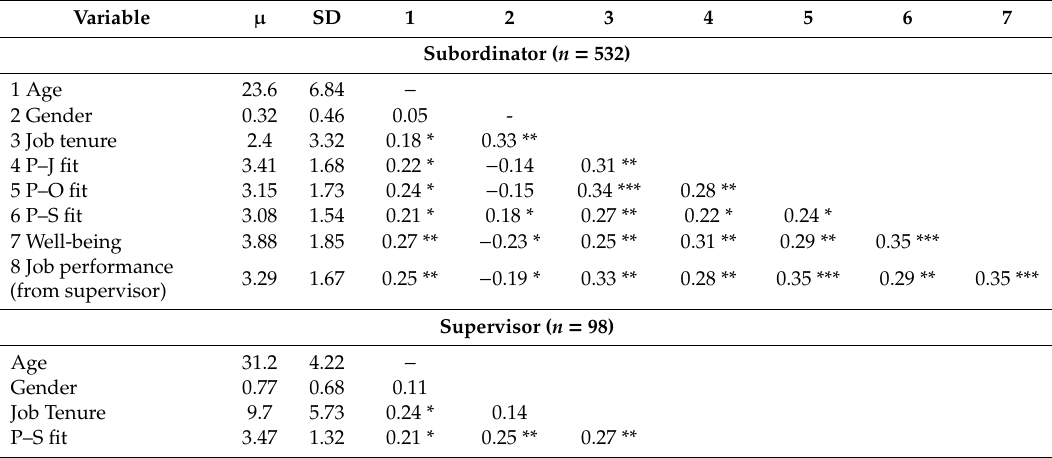
Table 3. Mean scores, standard deviations, and correlations among study